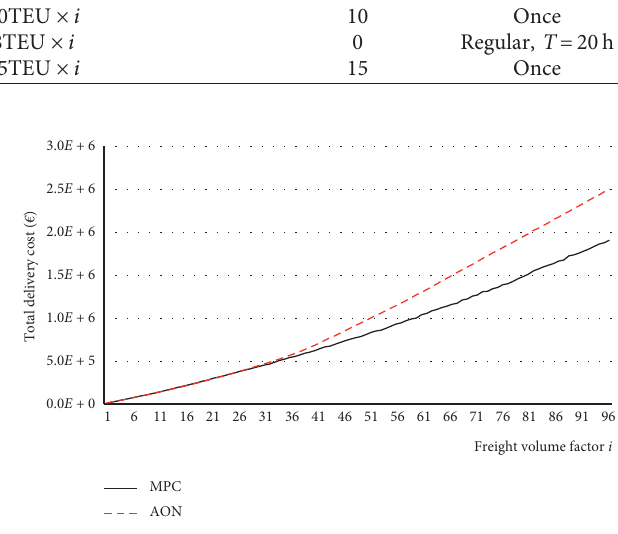
Figure 7: Total transport cost comparison in different freight volume